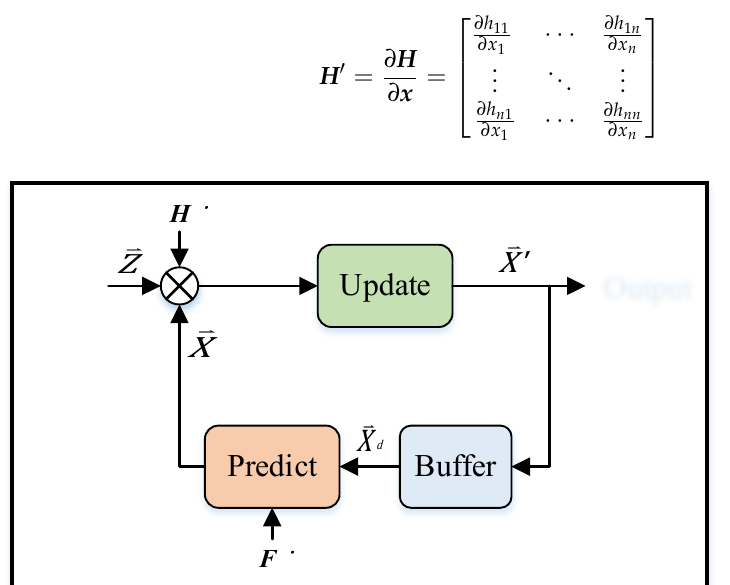
Figure 5. The architecture of the improved adaptive Kalman filter (IAKF) algorithm.